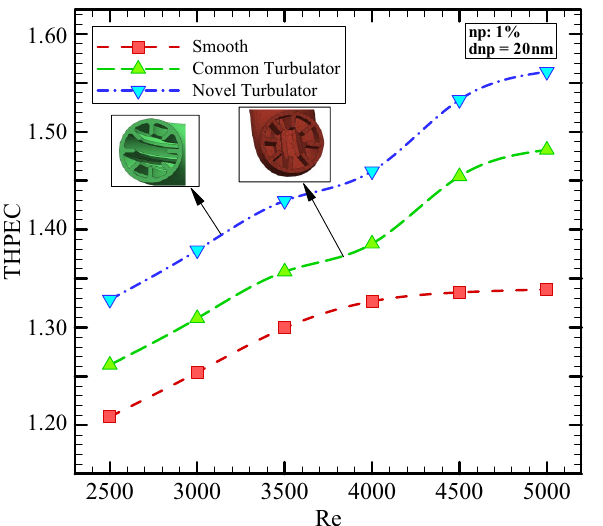
Figure 12. The THPEC index variation versus Re in three different helical heat exchangers filled with nanofluid ( φ = 1% and d np = 20 nm).